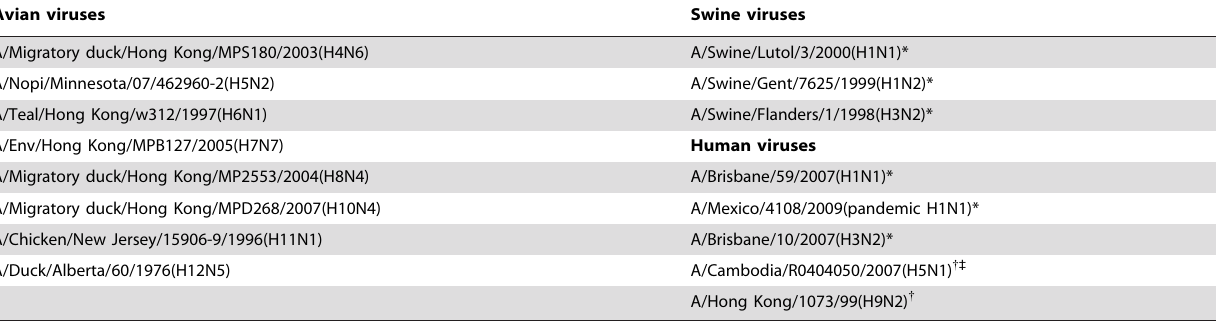
Table 1. Viruses used in serological